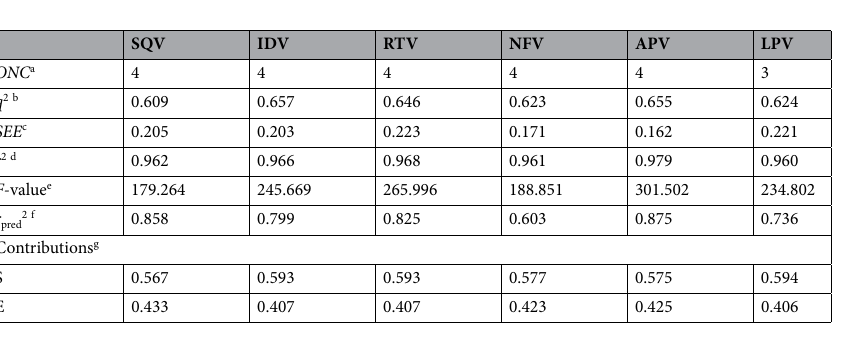
Table 1. Summary of statistical data for MB-QSAR analyses. a ONC : optimal number of components. b q 2 : cross-validated squared correlation coefficient from leave-one-out (LOO). c SEE : standard error of estimate from non-cross-validation. d r 2 : square of the correlation coefficient of non-cross-validation. e F -value: F -test value. f r pred 2 : square of the correlation coefficient calculated from the test set. g Field contributions: S = steric field, E = electrostatic